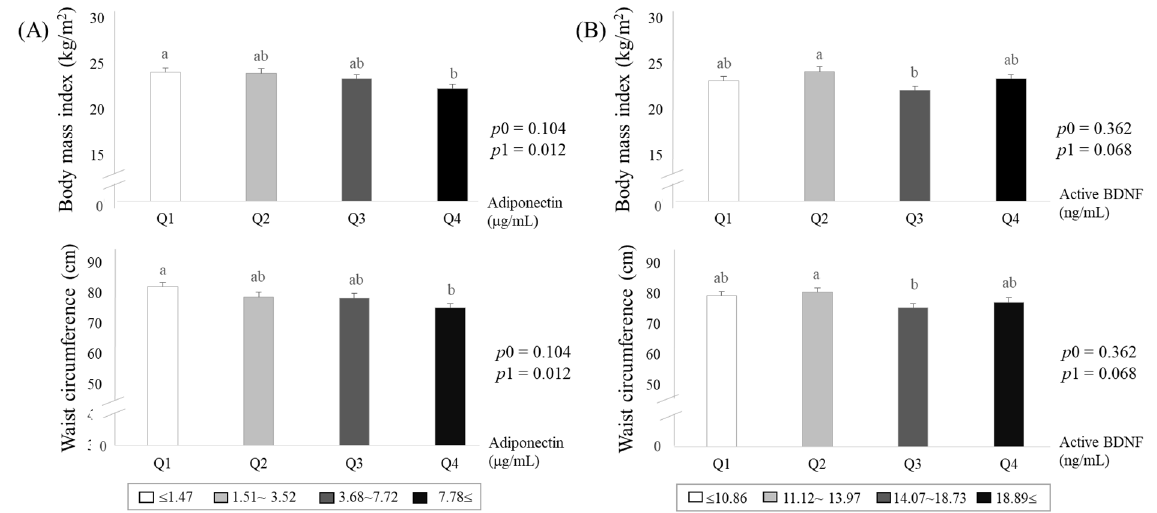
Figure 3. Adiposity estimated by body mass index and waist circumference according to circulating levels of adiponectin ( A ) and mature-brain-derived neurotrophic factors (BDNF) ( B ). Means ± S.E. tested by one-way analysis of variance (ANOVA) ( p 0), and general linear model by Bonfferoni correction with adjustment for age, smoking, drinking menopausal status, and total calorie intake ( p 1). Sharing the same alphabet letter (a or b) indicates no statistical significance among the values.